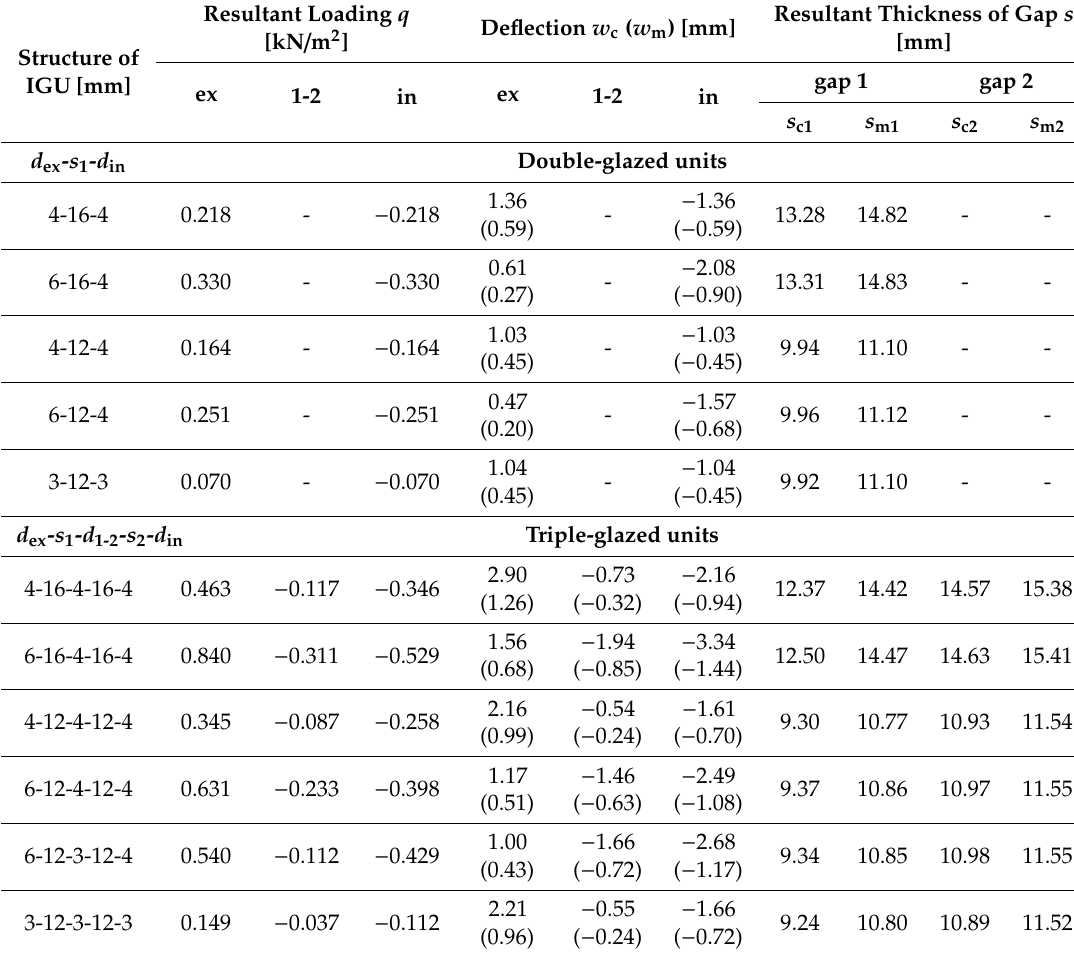
Table 2. Static quantities and gap thicknesses in IGUs—under reduced temperature conditions (Variant 1).